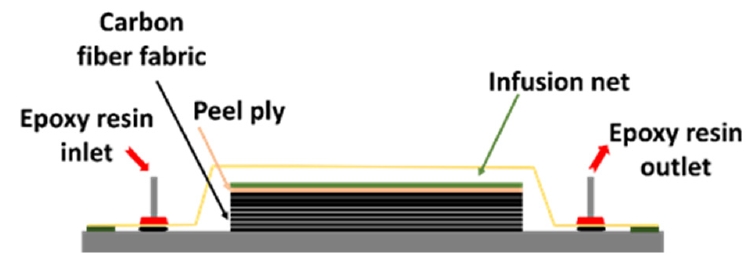
Figure 5. The studied vacuum infusion process.